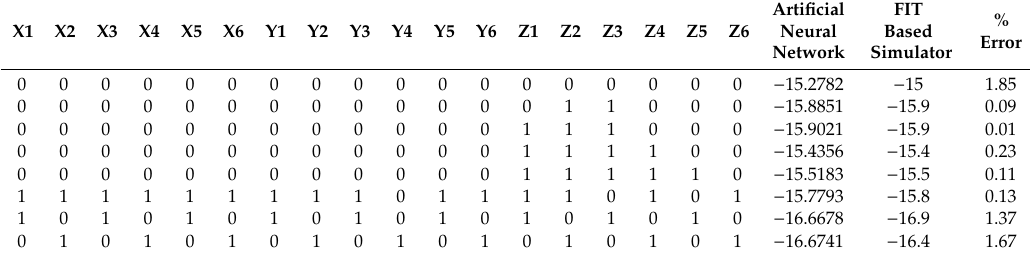
Table 2. Comparison of transmission values of eight unknown resonator